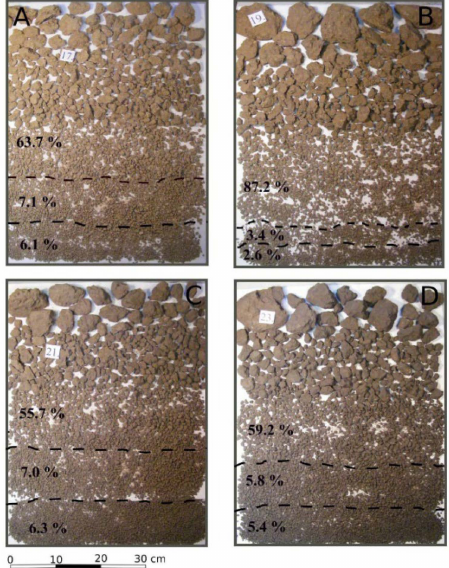
Figure 4. Soil aggregate distribution in air-dry conditions (plow horizon, aggregates >3 mm) for